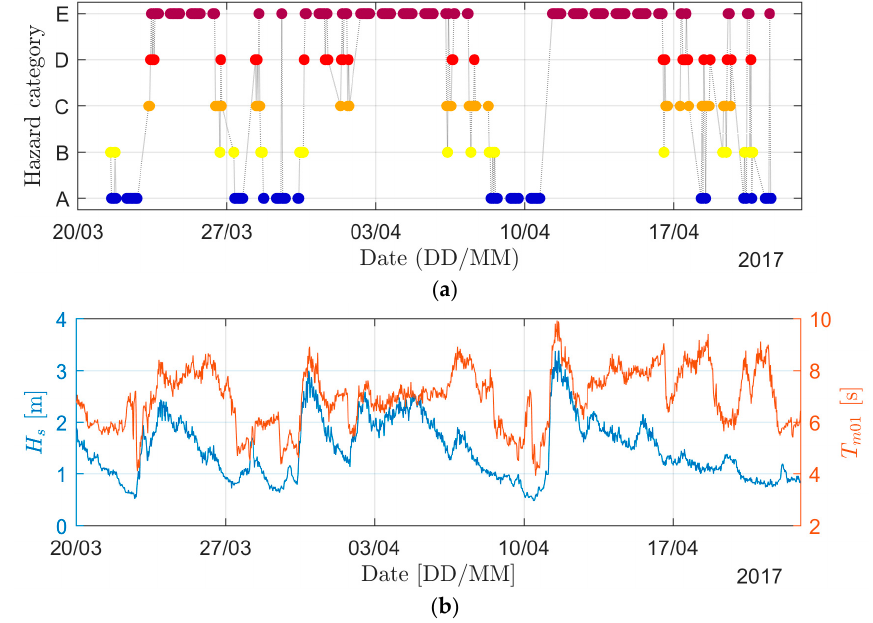
Figure 14. ( a ) Time series of the hazard category at transect N2 for the first month of camera deployments (21/03/2017 to 21/04/0217). See text in Section 5.3, Figure 13, and Table 2 for further explanation. ( b ) Time series of significant wave height ( H s ; blue line and left y-axis) and spectral mean wave period based on the first positive moment of the energy spectrum ( T m 01 ; red-orange line and right y-axis) from the wave buoy deployed in 30 m of water offshore of the platform (see Figure 1c for location) for the first month of the camera deployments.